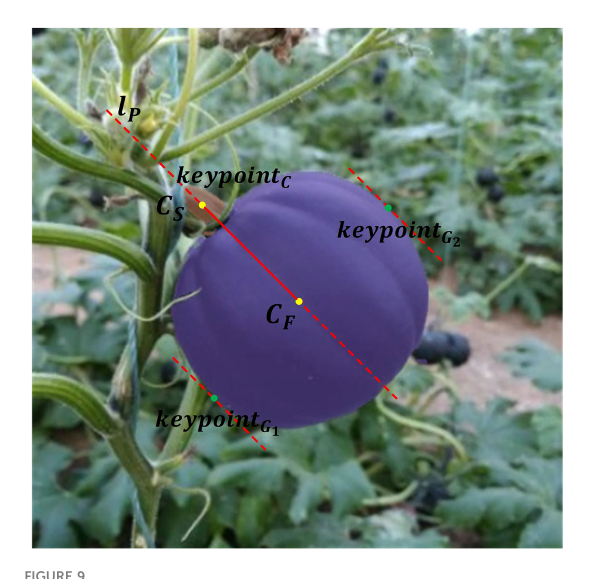
FIGURE 9 Estimation of pumpkin grasping and cutting